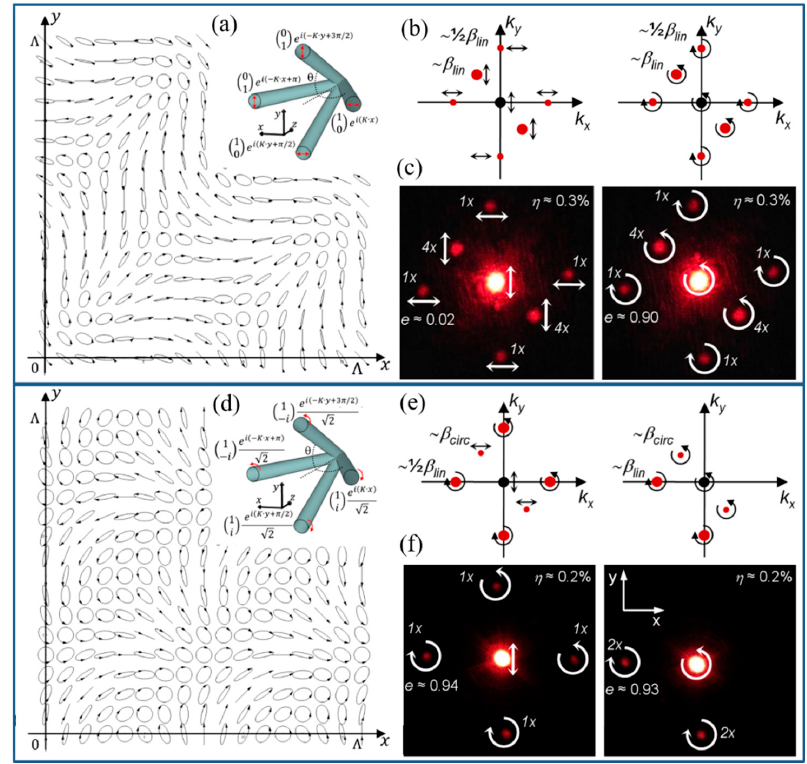
Figure 9. ( a ) 2D polarization pattern of four interference beams with orthogonal linear polariza- tion. Inset: Arrangement and polarization configurations of the interference beams. ( b ) Calculated and ( c ) experimental diffraction patterns for the 2D PG. ( d ) 2D polarization pattern and ( e ) calculated and ( f ) experimental diffraction patterns for the 2D PG based on four interference beams with circular polarization. Reproduced with permission from Reference [46] © The Optical